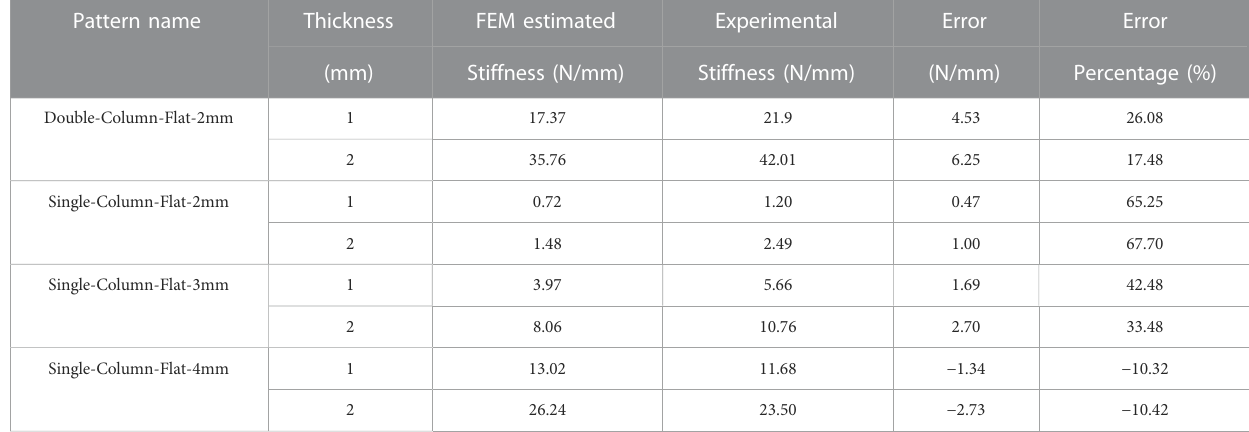
TABLE 5 Comparison between FEM estimated stiffness and experimental stiffness of kirigami samples with error and error